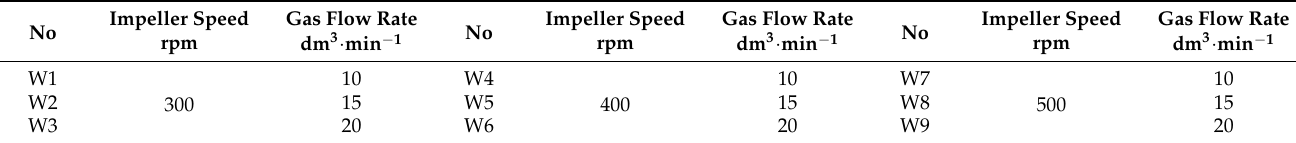
Table 2. Variants of the research conducted for different processing